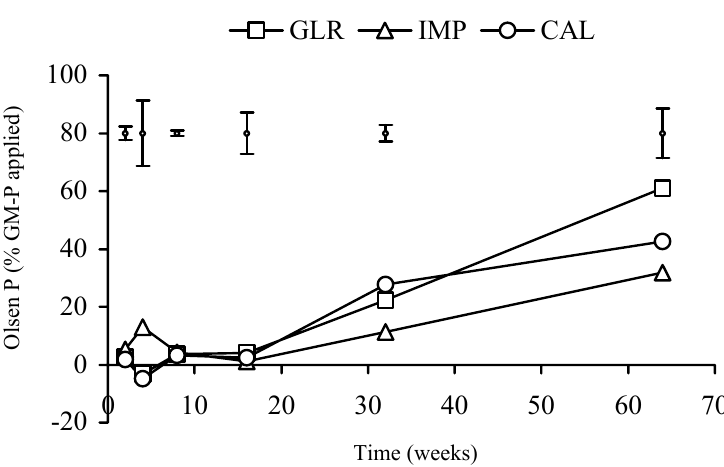
FIGURE 6. Net changes in Olsen P (as %GM-P applied) during incubation of a tropical soil treated with GMs. Bars = LSD 0.05 .